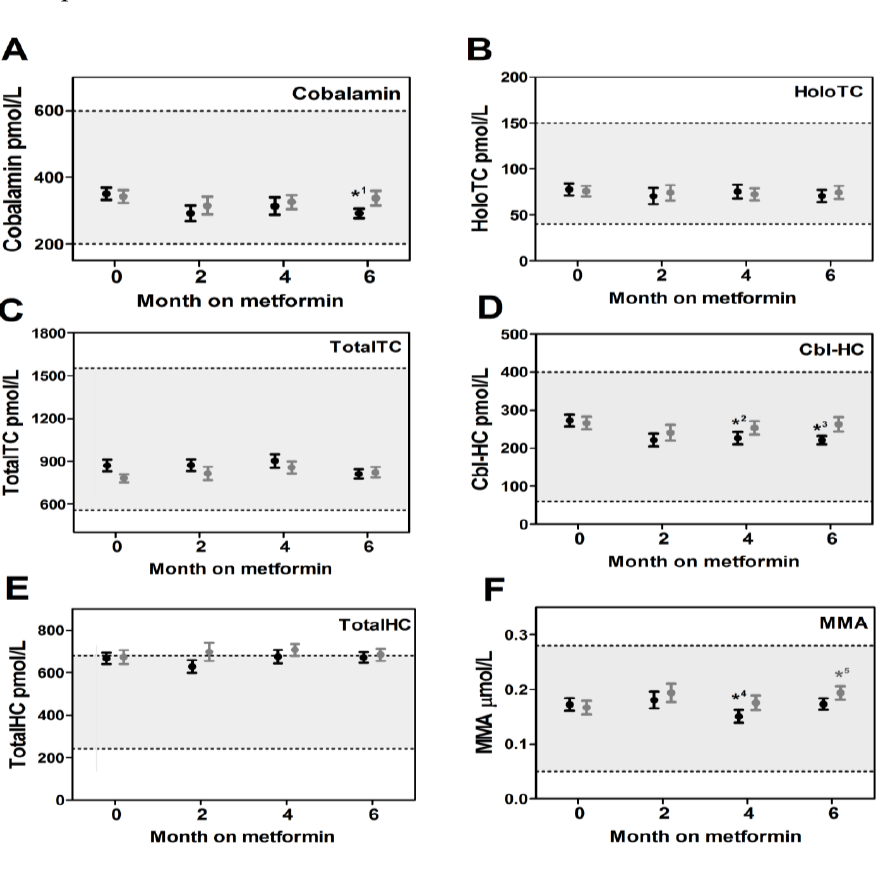
Figure 1. Serum markers for cobalamin status in women with Polycystic Ovary Syndrome (PCOS) on treatment with metformin or placebo. Serum cobalamin ( A ), holotranscobalamin (holoTC) ( B ), totaltranscobalamin (totalTC) ( C ), cobalamin-haptocorrin (Cbl-HC) ( D ), totalhaptocorrin (totalHC) ( E ), and methylmalonic acid (MMA) ( F ) in women with PCOS before and during treatment with metformin (black) or placebo (grey). To compare changes between baseline and a given time point, the two-tailed paired t -test or the Wilcoxon signed rank test was used. Due to incomplete sample material, the number of baseline paired samples varied with the time points (metformin: two ( n = 16), four ( n = 26), and six ( n = 23) months; placebo: two ( n = 16), four ( n = 20), and six ( n = 23) months). Results are presented as mean with SEM. Reference intervals for healthy adults [19,20,22,23] are indicated as a light grey fill between dotted lines. Reference interval for Cbl-HC was calculated from [20]. p -values ≤ 0.05 were considered statistical significant and are denoted with asterisks above the error bars. * 1 p = 0.003, * 2 p = 0.012, * 3 p = 0.0009, * 4 p = 0.02, * 5 p =